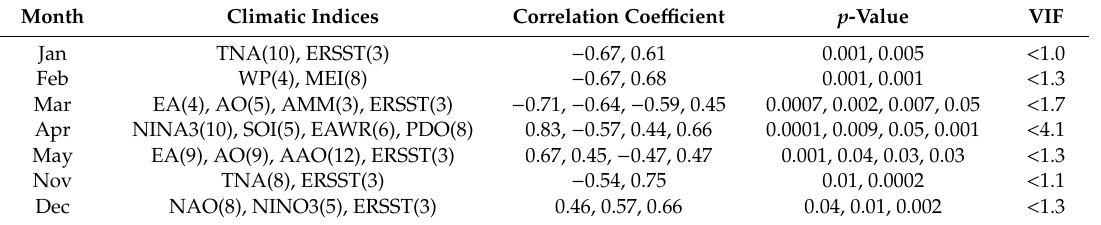
Table 3. List of teleconnection indices used for each month (the number in the ( ) means the months lagged).